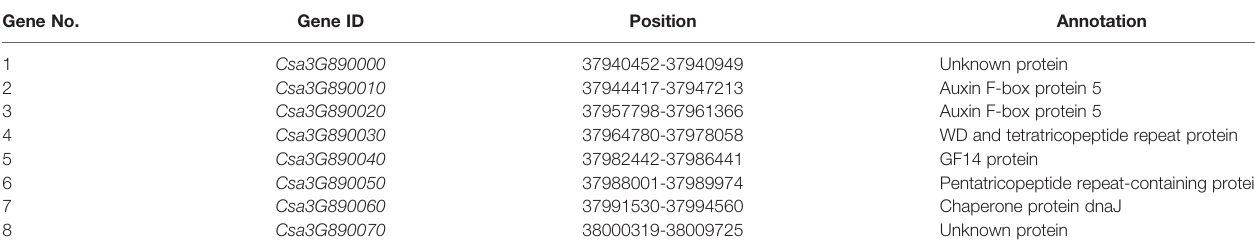
TABLE 2 | Predicted genes in the 73 kb region of cucumber chromosome 3 harboring virescent gene v-2 . Gene No. Gene ID